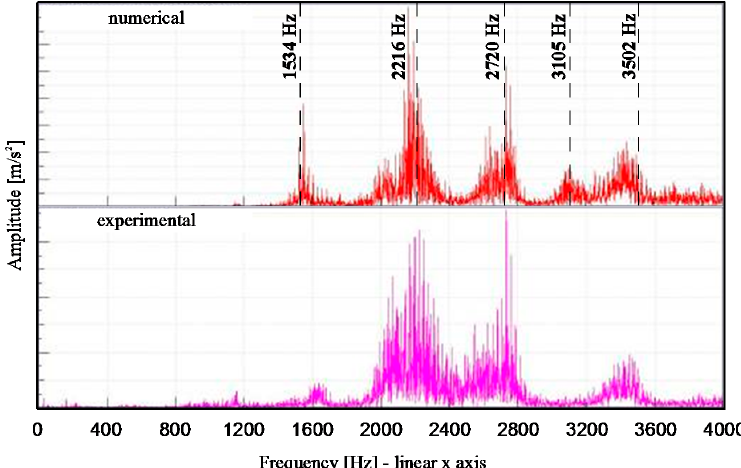
Figure 7. Narrow-band numerical ( up ) and experimental ( down ) comparison of the acceleration at the measurement point.